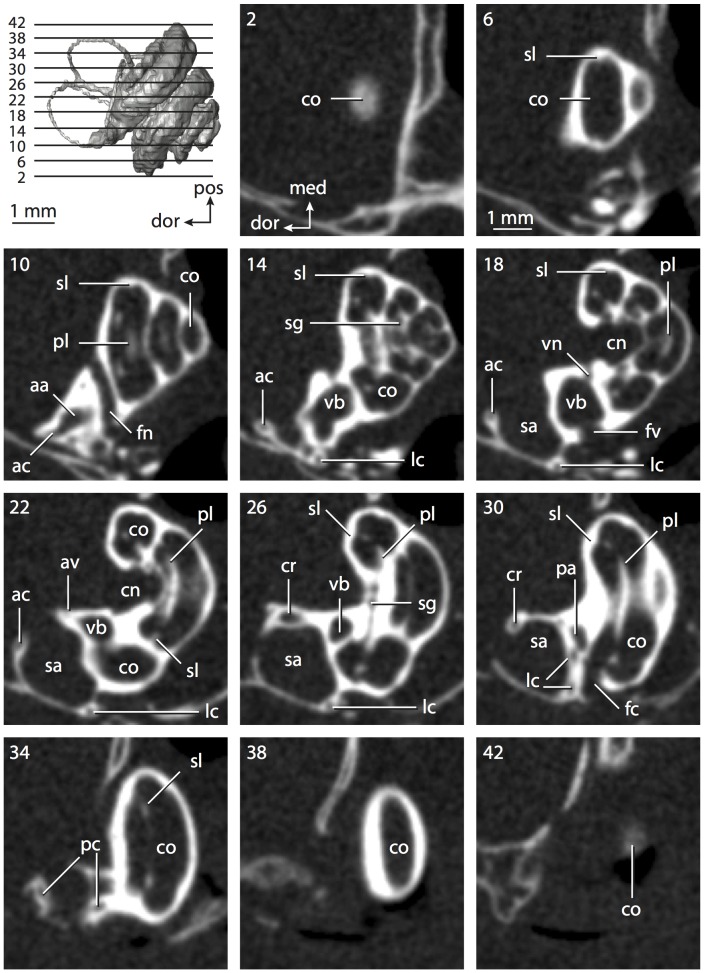
CT slices through ear region ofRhinolophus ferrumequinum.
Abbreviations listed at the end of the Materials and Methods section.